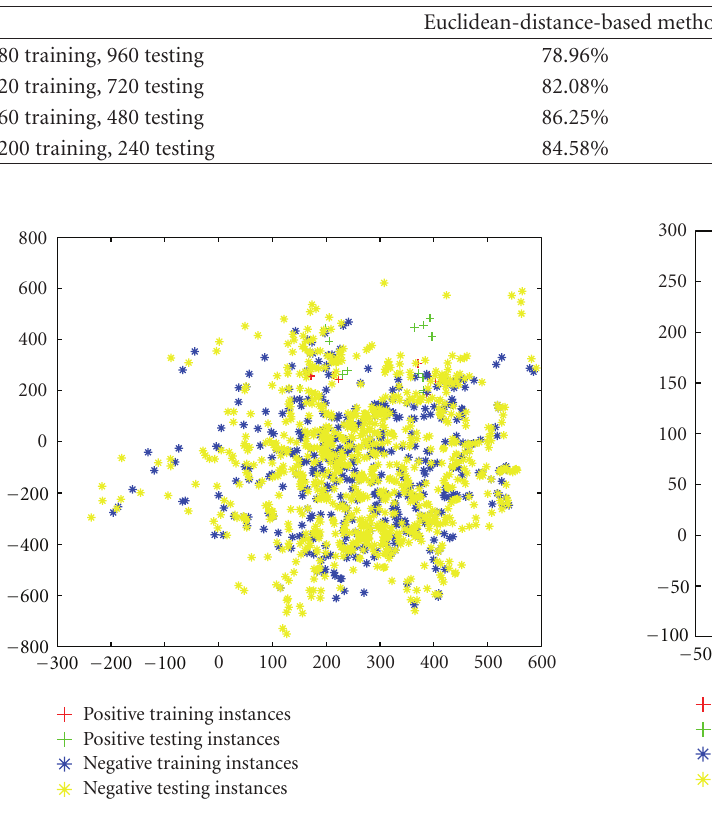
Figure 6: Samples distribution with Euclidean distance metric. Figure 7: Samples distribution with new distance metric using LMNN.